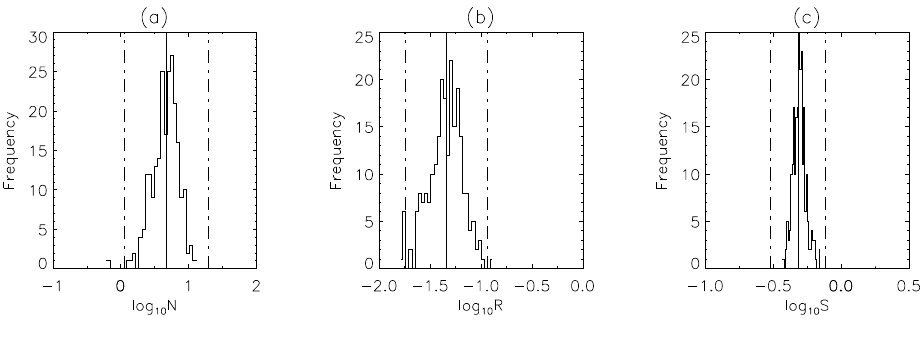
Fig. 1. Histograms of number density (a) , median radius (b) , distribution width (c) as retrieved from synthetic aerosol extinction in the maximum noise scenario. The vertical lines indicate the a priori mean state (solid), and the a priori mean plus or minus one standard deviation (dash-dot).